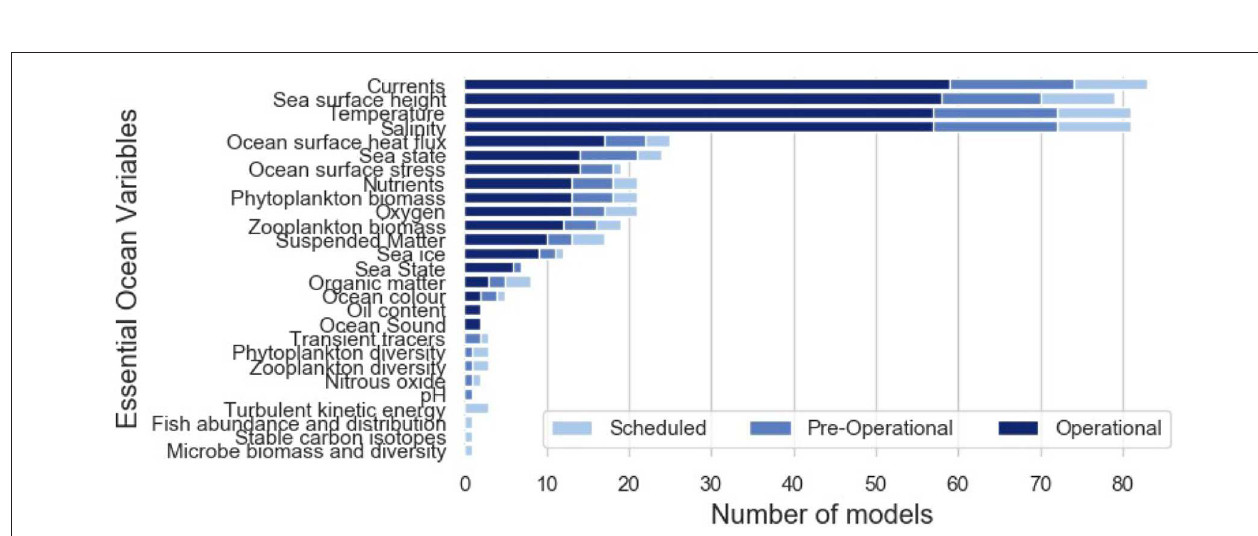
FIGURE 3 | Representation of different types of model in the operational modeling capacity survey.